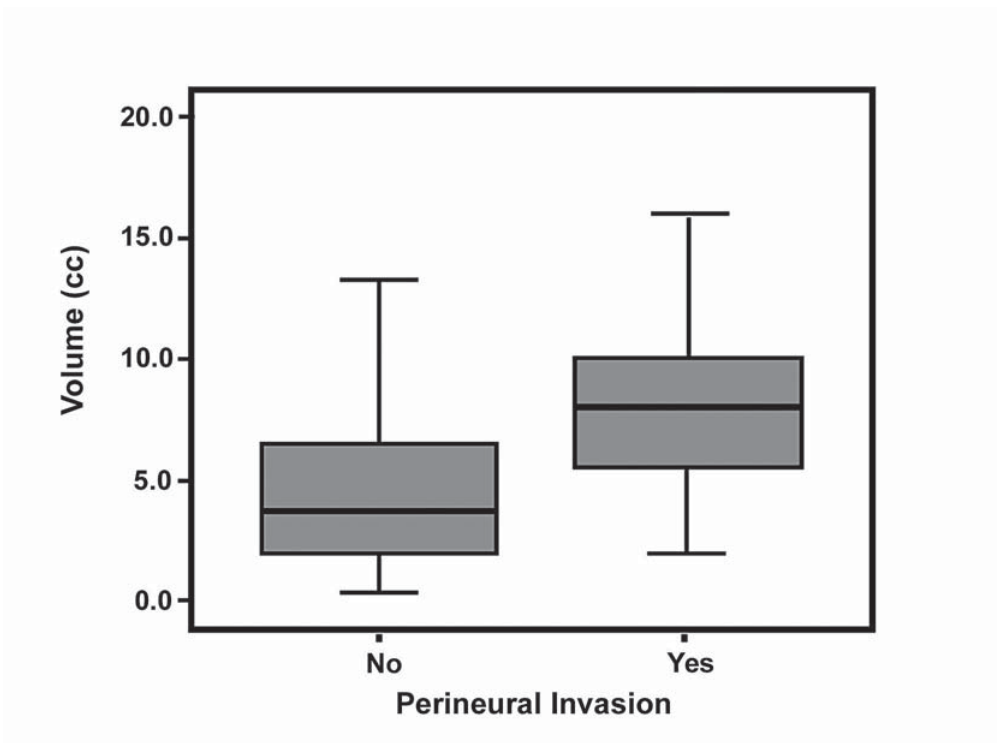
Figure 1 – Tumor volume box-plot according to the presence of perineural